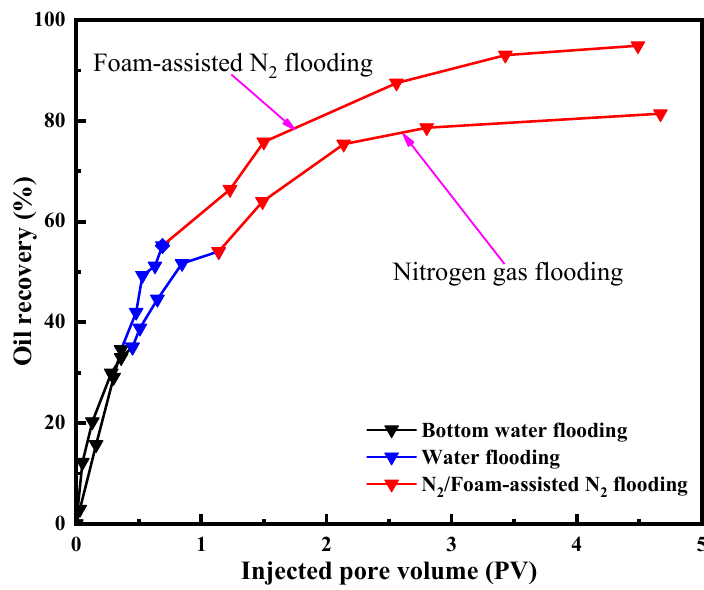
Figure 12. Dynamic oil recovery comparison.